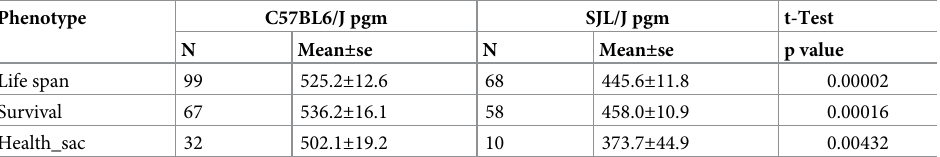
Table 2. Effect of the paternal grandmother of the F2 cross on life span of G59S-hDCTN1